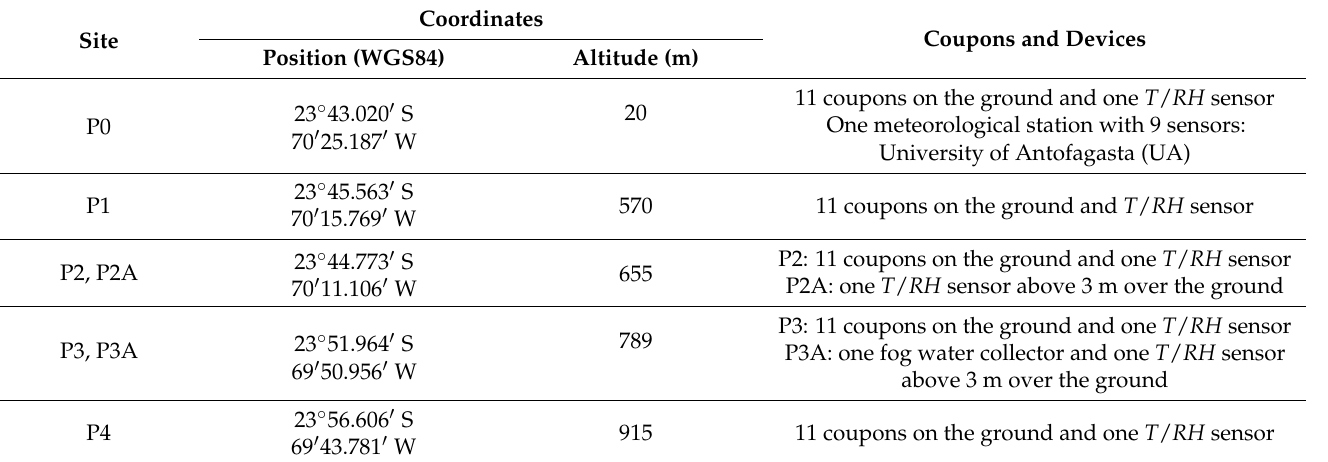
Table 1. Geographical locations of the selected experimental